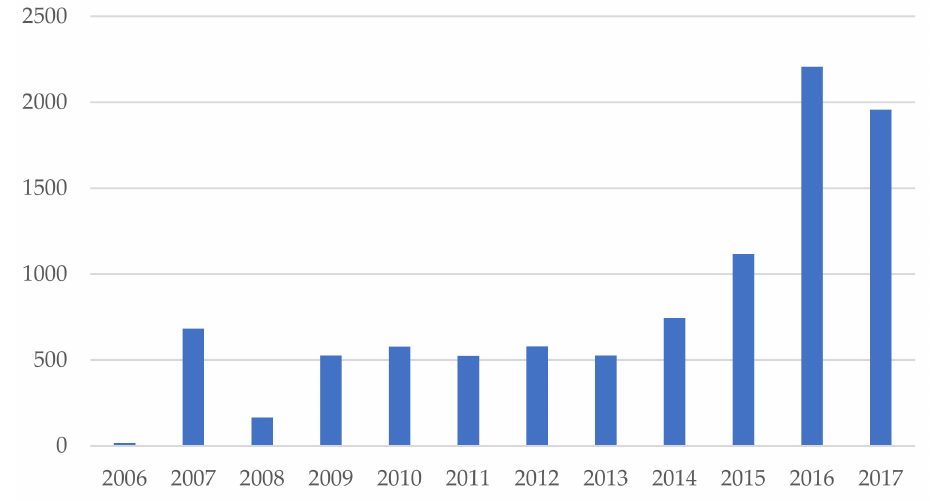
Figure 5. Number of citations per